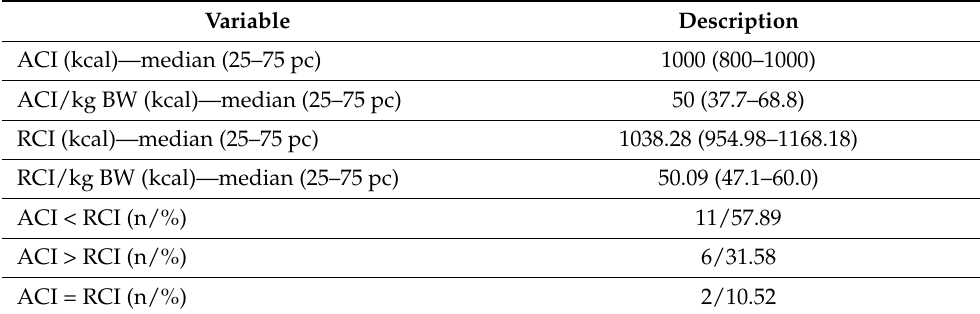
Table 2. Recommended and actual caloric intake of patients in this study (n = 19).